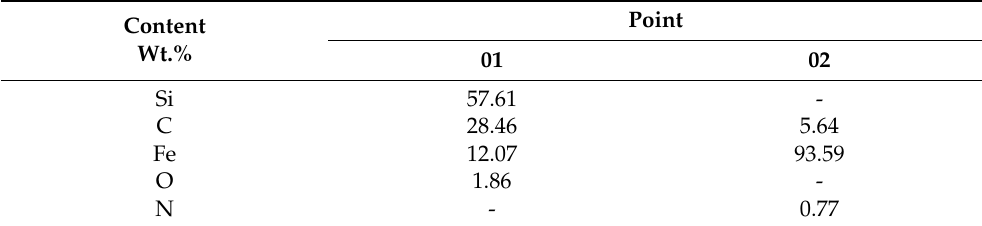
Table 6. Point EDXS analysis on the worn steel fibres of M0_CN (see relevant SEM micrograph in Figure